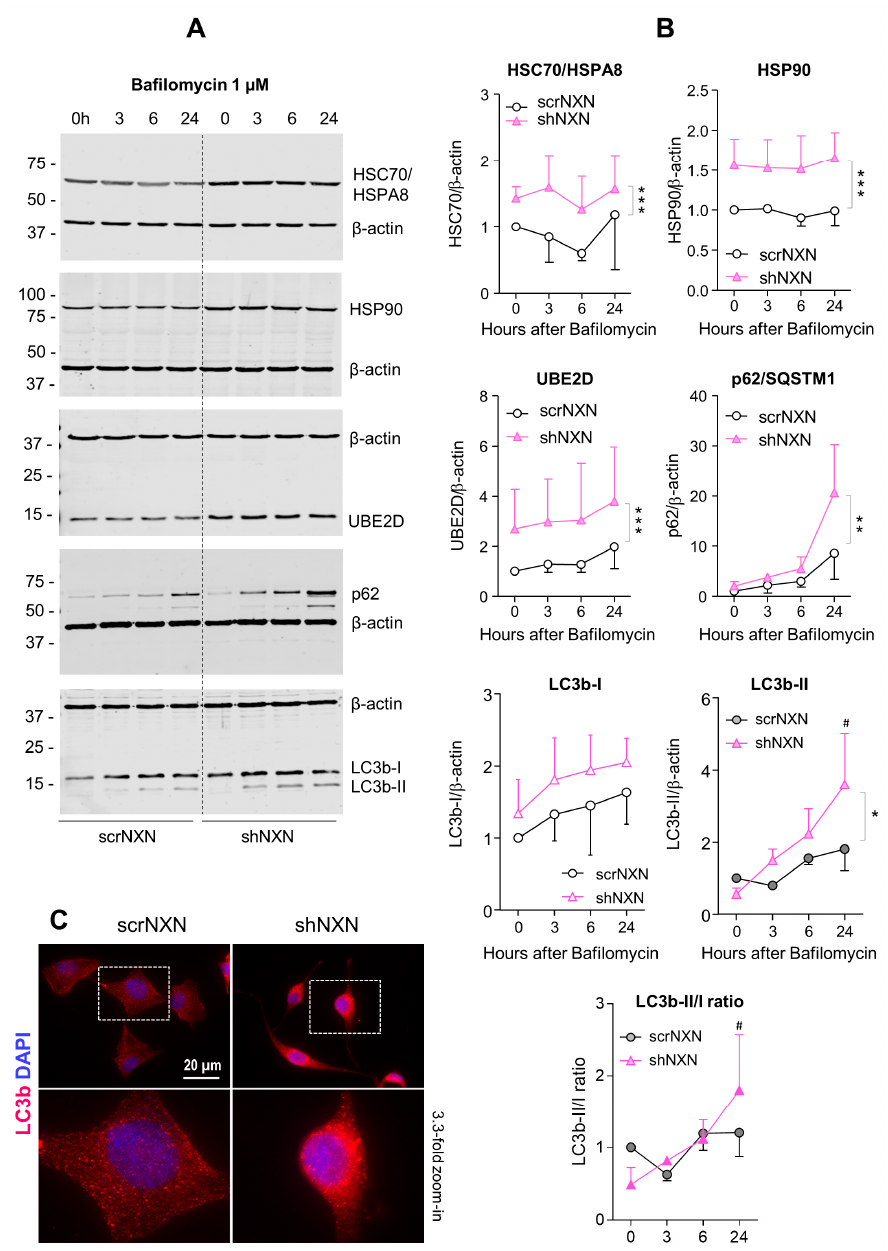
Figure 4. Western blot analysis of autophagy markers upon bafilomycin stimulation. ( A , B ) scrNXN and shNXN neuroblastoma cells were stimulated with 1 µ M bafilomycin to block the lysosomal acidification and autophagolysosomal cargo breakdown. Exemplary blots and quantification show the time courses of heat shock cognate, HSC70/HSPA8, heat shock protein, HSP90, ubiquitin 2 ligase (UBE2D), sequestosome 1, SQSTM1/p62 and LC3b-I and LC3b-II, and the LC3b-II/I ratio. Blots were sequentially developed, and infrared images superimposed. Intensities were normalized for blot loading and show the mean + SD of 3 experiments. Statistical comparison by Wilcoxon matched pairs rank test. Asterisks indicate differences between groups. * p < 0.05; ** p < 0.01, *** p < 0.001. The # shows a significant increase from baseline. Raw Western blot data in Supplementary Figures S2 and S3. ( C ) Immunofluorescence analysis of LC3b (LC3-I and LC3b-II) in naïve scrNXN and shNXN SH-Sy5Y cells. The scale bar is 20 µ M. The dashed rectangle reveals the area, which was used for 3.3-fold zoom-in of the bottom panel. Please note the different morphology of the faster proliferating shNXN